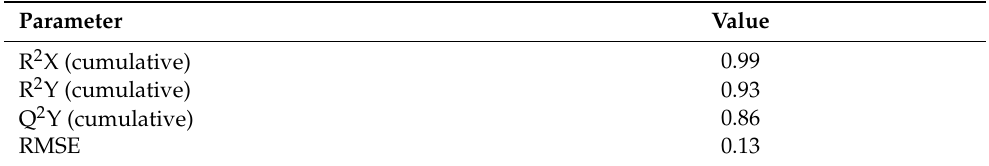
Table 6. Metrics of the PLS-DA classification model.